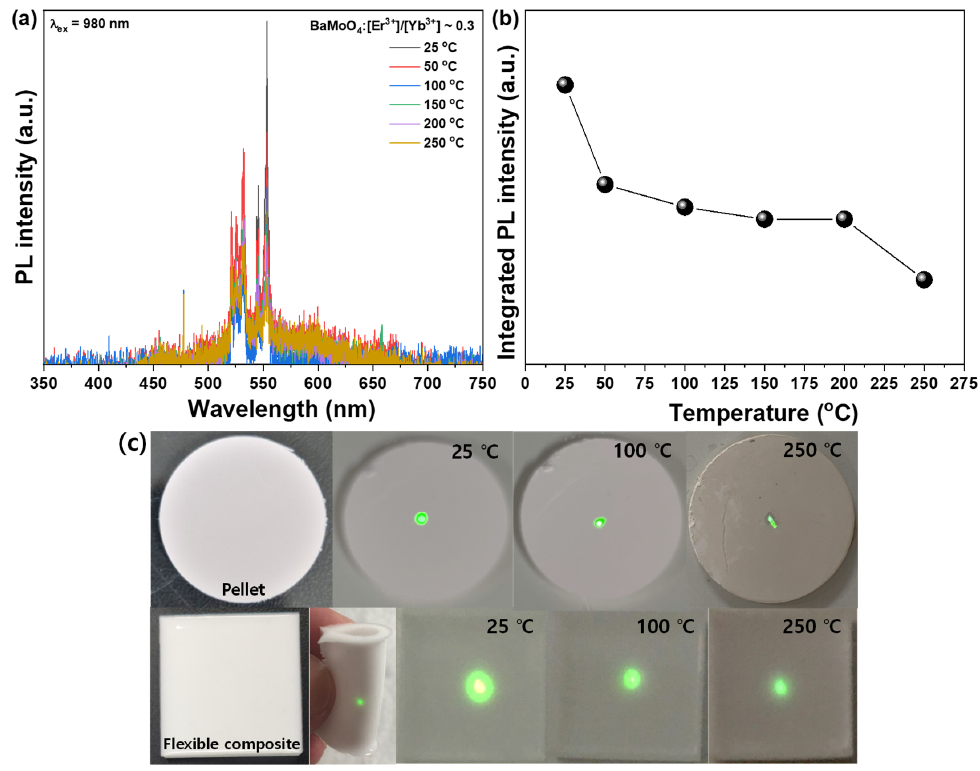
Figure 6. ( a ) PL spectra of changing temperature; ( b ) Integrated PL intensity; and ( c ) Photograph of pellet and flexible composite under 980 nm at 100 mW of BaMoO 4 :[Er 3+ ]/[Yb 3+ ] ~0.3 up-conversion phosphors.